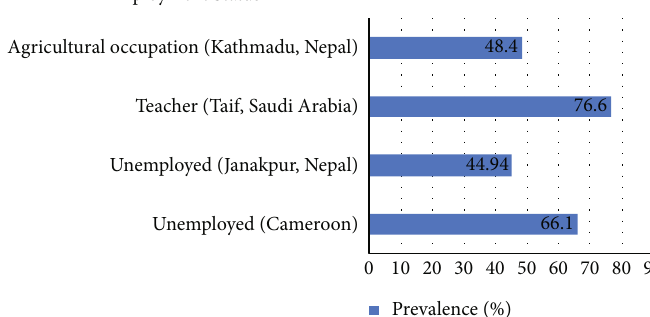
Figure 3: Prevalence of VVC according to employment status in di ff erent countries. Abbreviation: VVC: vulvovaginal candidosis.